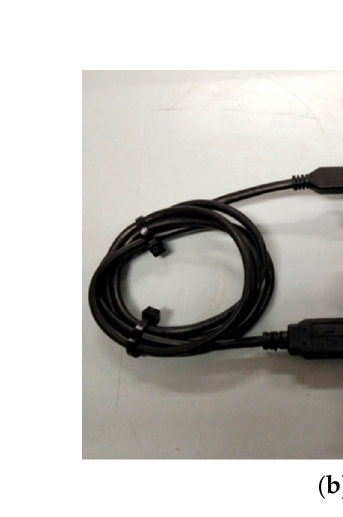
Figure 6. ( a ) Alternative on-device intelligence arrangements involving an external accelerometer, a Raspberry Pico, and a LoRa32u4 radio module, from left to right, respectively. ( b ) Gateway and sink node implementation using Raspberry Pi 3 Model B and a LoRa radio.